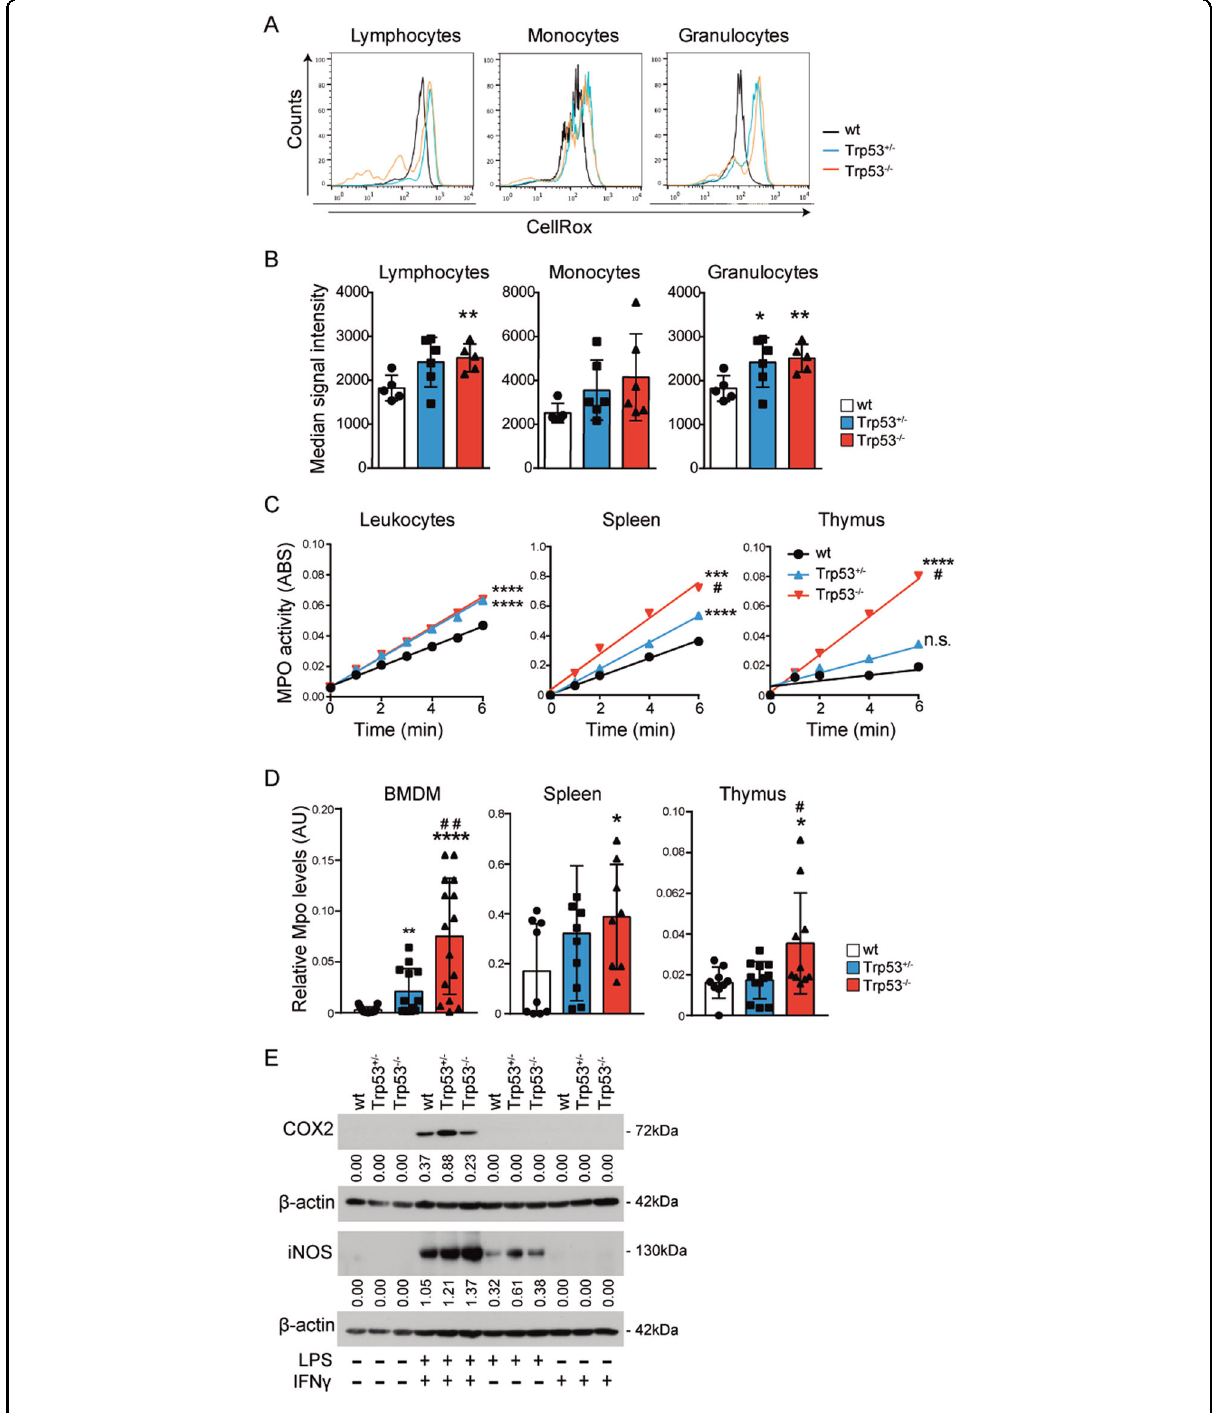
Fig. 2 (See legend on next